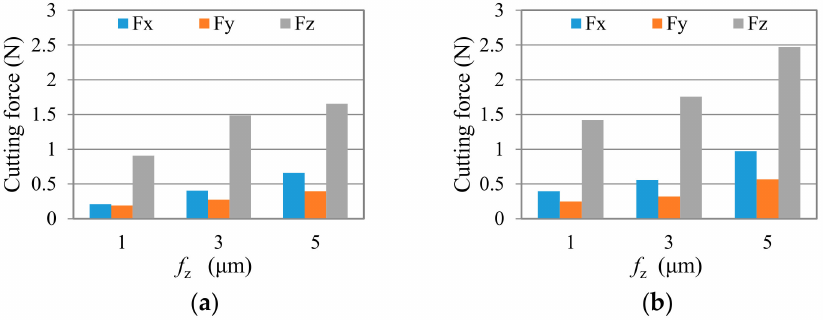
Figure 11. Cutting force in the test group TC after cutting length of less than 55 mm, ( a ) a p = 2 µ m, and ( b ) a p = 4 µ m.